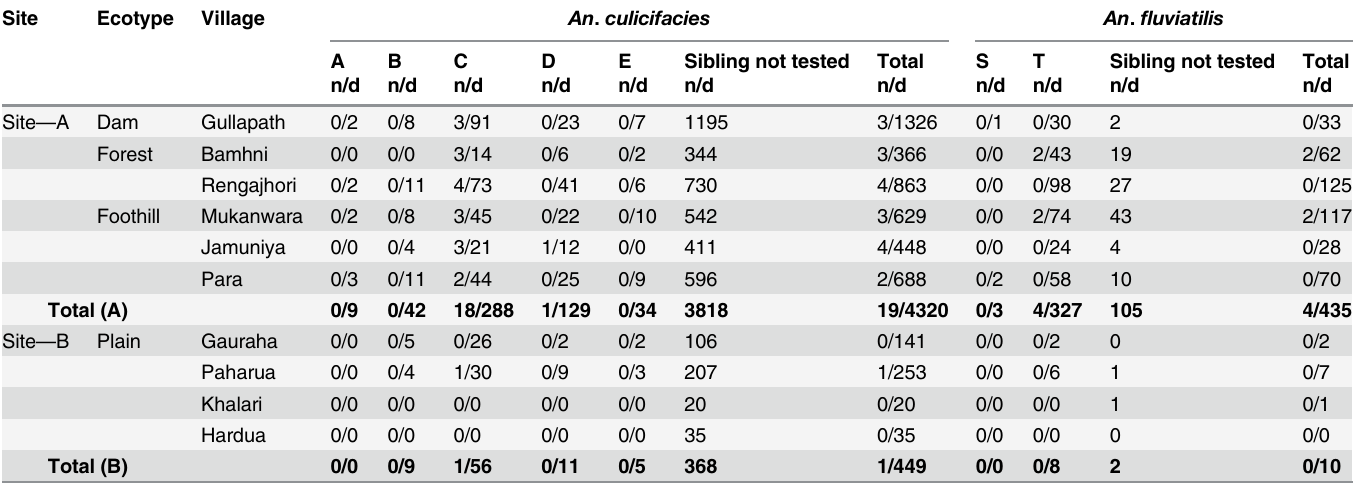
Table 2. Ecotypes and village wise distribution of sibling species and sporozoite positive of An . culicifacies , An . fluviatilis in Bargi and Sihora PHCs, Jabalpur, Madhya Pradesh.